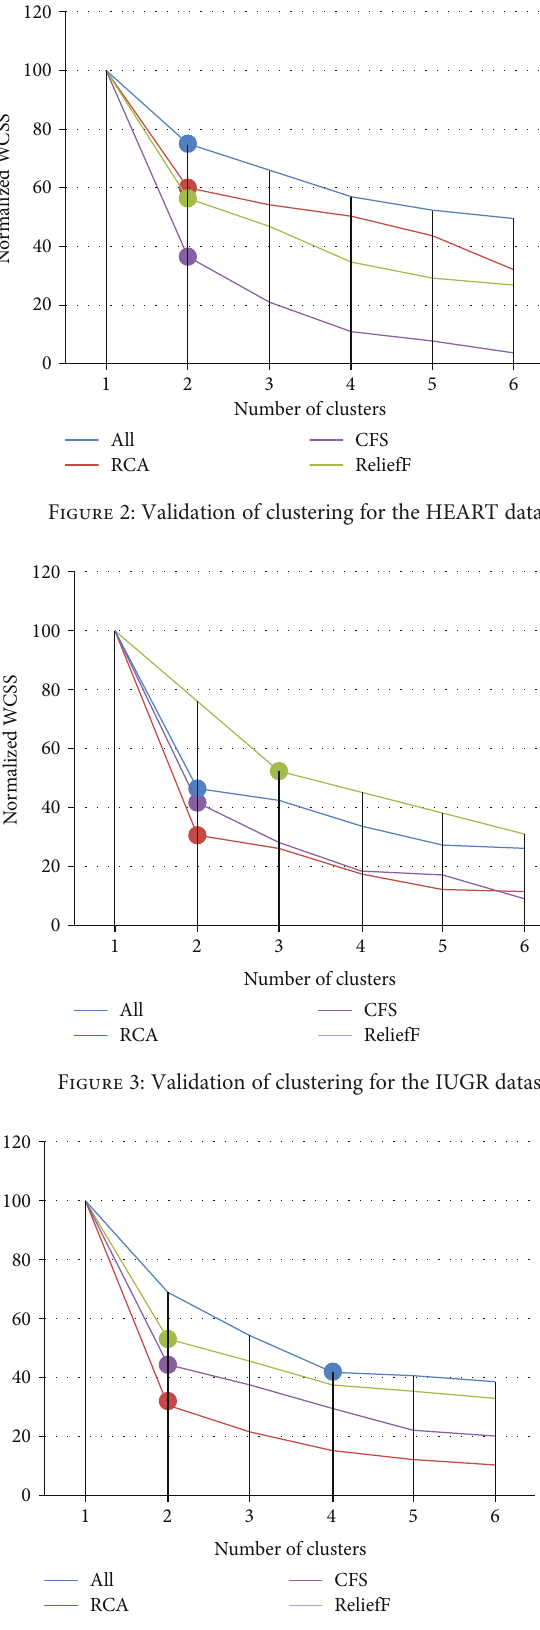
Figure 4: Validation of clustering for the CORONARY